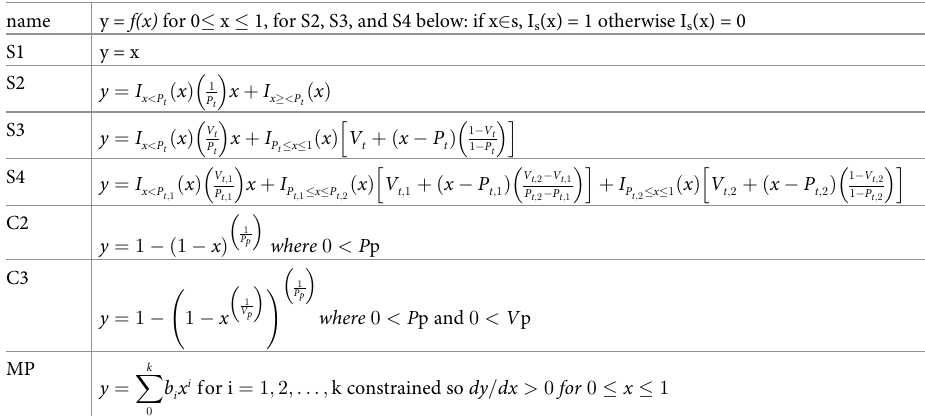
Table 1. Formulae for the seven choices for f(x)